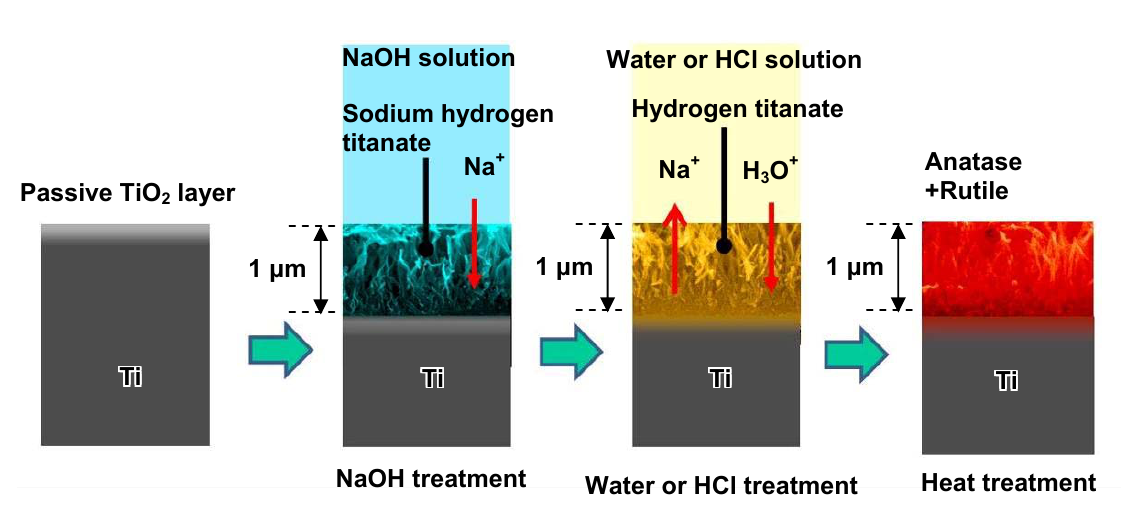
Figure 19. Surface structural change of Ti metal by NaOH, water or HCl and heat